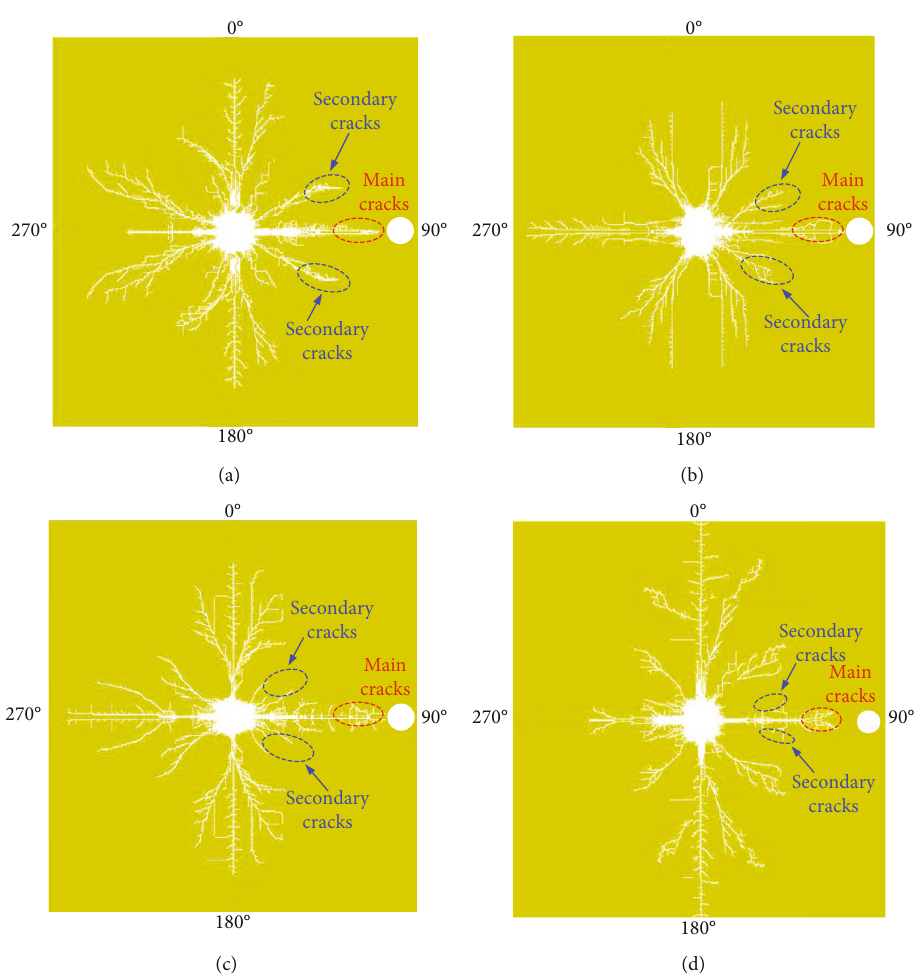
σ σ σ σ h = v = 0 MPa; (b) h = 30 MPa, v = 0 MPa; (c) h = 30